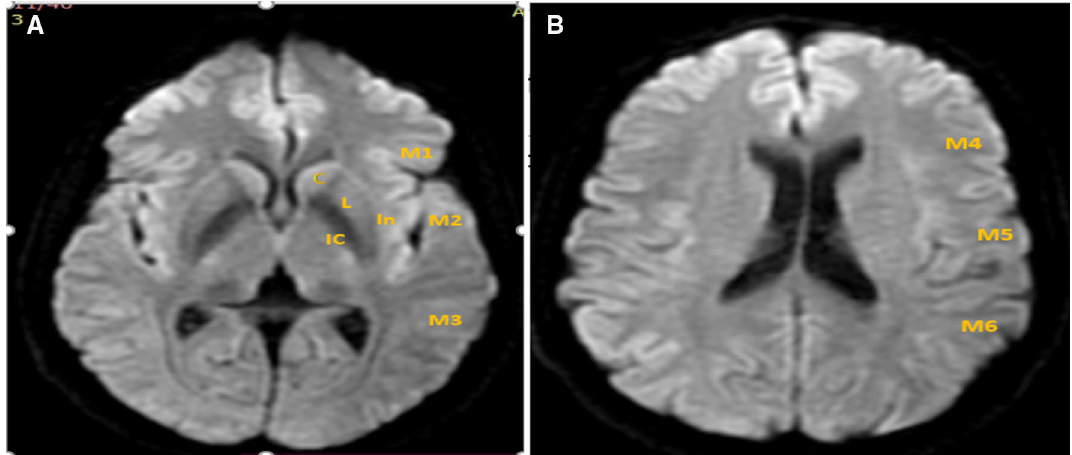
Fig. 1 Alberta Stroke Program Early CT Score (ASPECTS) in diffusion weighted imaging. A axial DWI at the level of the basal ganglia showing seven areas assessed in ASPECTS including caudate nucleus (C), insular ribbon (In), internal capsule (IC), lentiform nucleus (L), anterior middle cerebral artery (MCA) cortex (M1), MCA cortex lateral to the insular ribbon (M2), and posterior MCA cortex (M3). B Axial DWI at supraganglionic level showing the other three areas assessed in ASPECTS including M4, M5 and M6 which are the anterior, lateral, and posterior MCA territory immediately superior to M1, M2, and